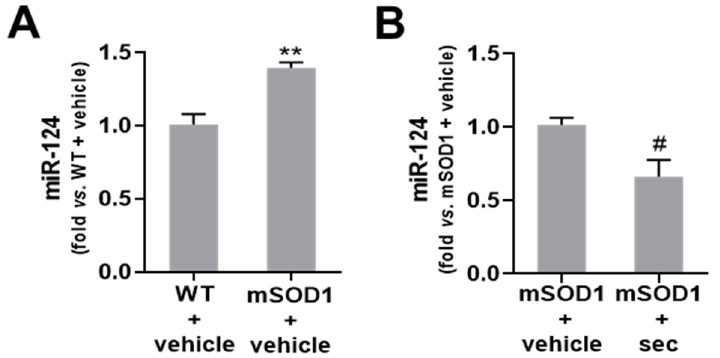
Figure 3. The secretome from mSOD1 MNs transfected with anti-miR-124 abolishes the upregulation of miR-124 in the spinal cord (SC) of ALS mice after 3 weeks of intrathecal injection. Expression of miRNA-124 in the lumbar SC of ( A ) SOD1-G93A (mSOD1) mice injected at 12 weeks of age with the vehicle (basal media of NSC-34 motor neurons (MNs)) in comparison with the respective wild-type (WT) animals, and ( B ) mSOD1 mice injected with the secretome derived from anti-miR-124-treated mSOD1 MNs (mSOD1 + sec) in comparison with those injected only with the vehicle. The results were obtained at 15 weeks of age and were normalized to SNORD110. Data are expressed as fold change vs. ( A ) WT + vehicle and ( B ) mSOD1 + vehicle (mean ± SEM) from at least 5 animals per group. ** p < 0.01 vs. WT + vehicle; # p < 0.05 vs. mSOD1 + vehicle, unpaired and parametric t -test (with Welch’s correction when needed).